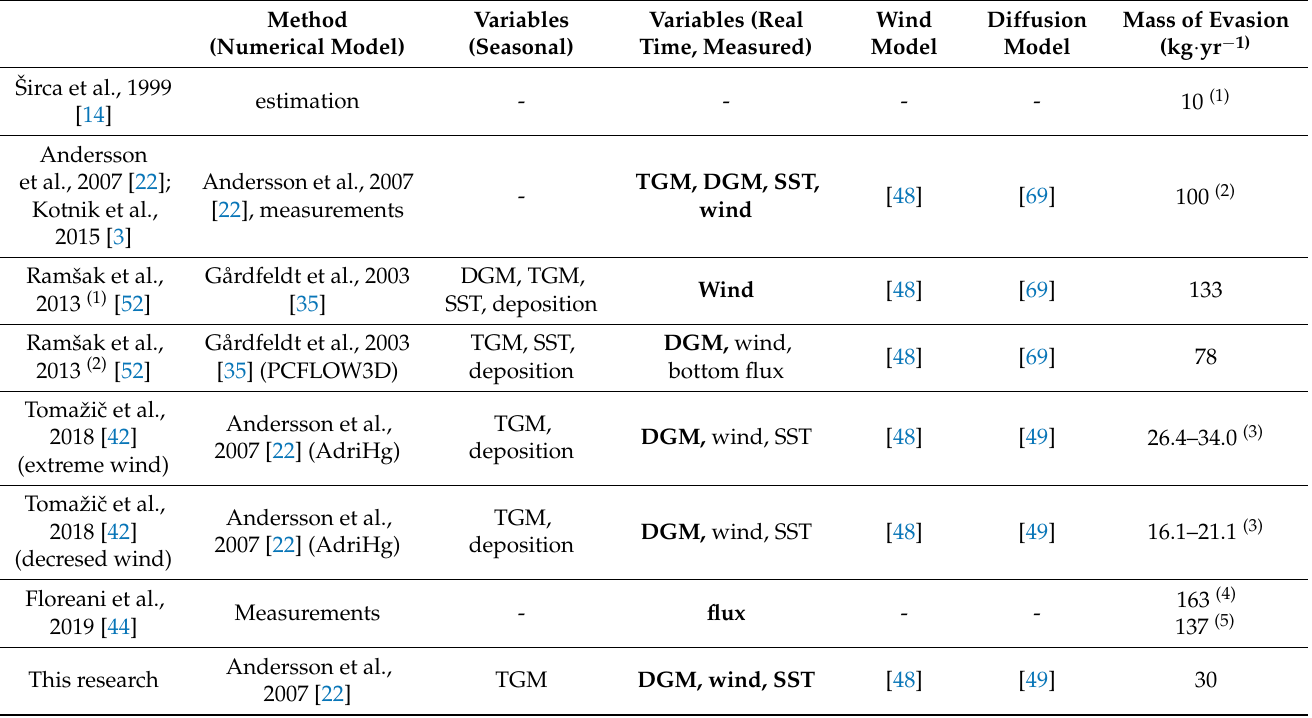
Table 2. Mass of Hg(0) evasion in the Gulf of Trieste reported in recent studies. Measured parameters are marked in bold